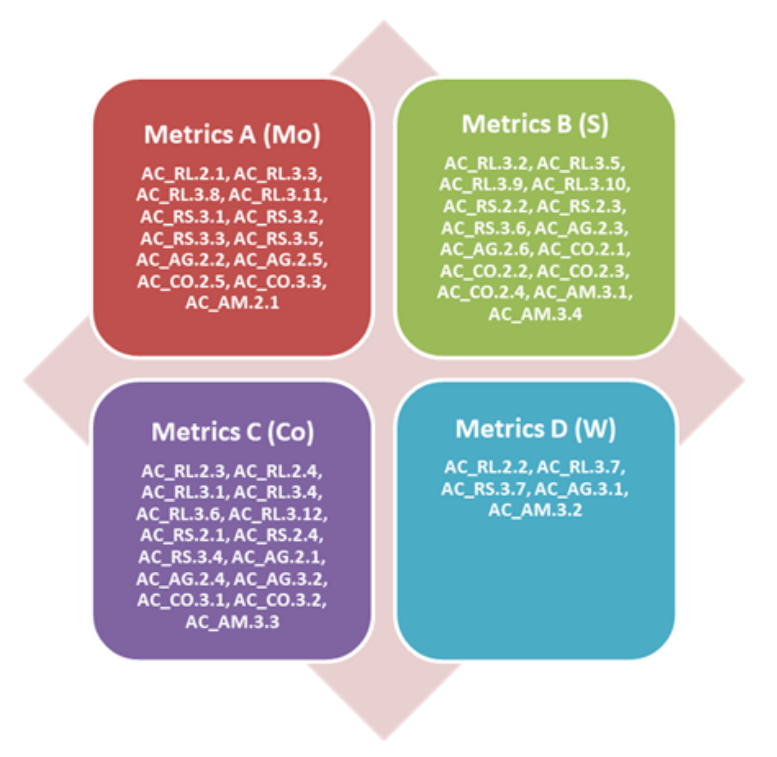
Figure 3. Priority Groups for the Performance Metrics